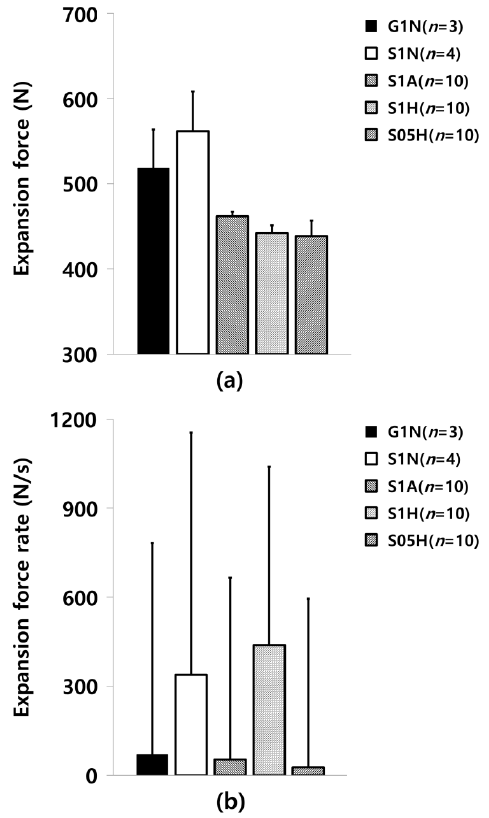
Figure 6. Al tube expansion experiment results: ( a ) expansion force; and ( b ) expansion force rate.